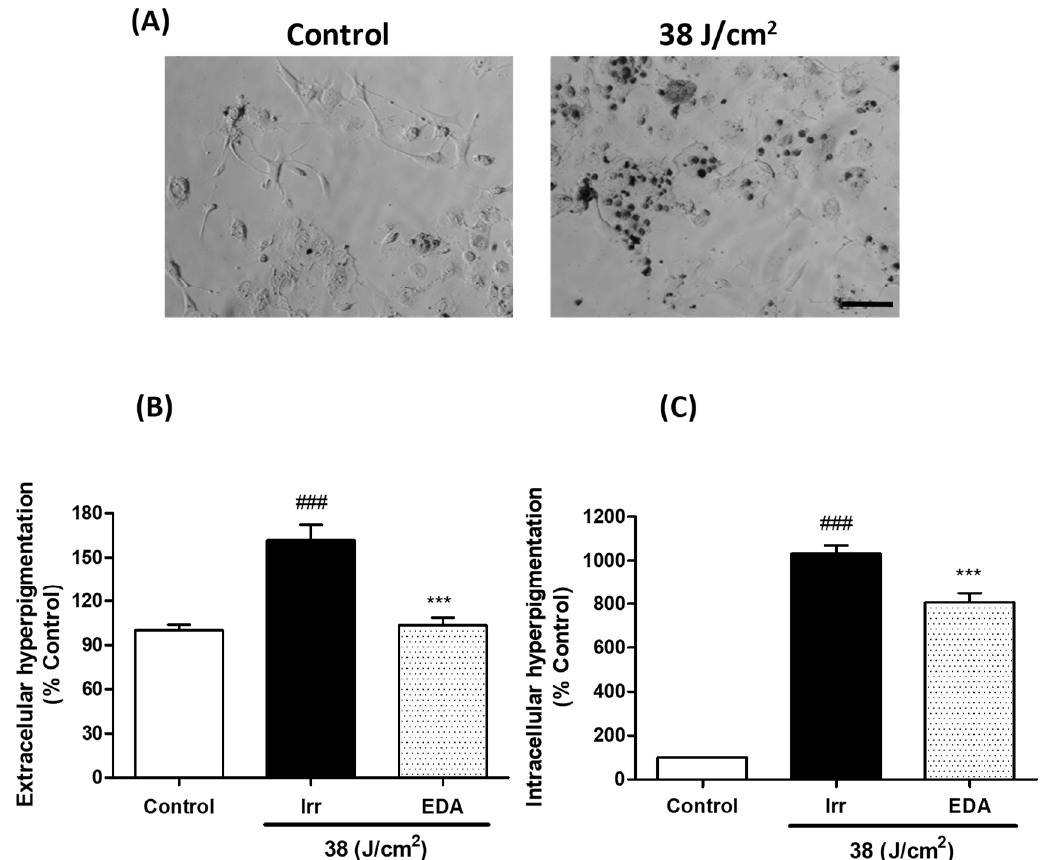
Figure 5. Extracellular and intracellular hyperpigmentation in melanocytes exposed to artificial blue light and pre-treatment with EDA. Microphotographs show how control and irradiated melanocytes have different amounts of melanin dark granules ( A ). Cells were incubated with EDA 0.1 mg/mL for 24 h, irradiated (38 J/cm 2 ), fresh medium replaced and extracellular ( B ) and intracellular ( C ) melanin pigments collected, solubilized and quantified 3 h later by absorbance measurements ( n ≥ 4). Data were normalized by mg protein and expressed as % of control cells. Data are shown as mean ±SEM. ### p < 0.001 vs control; *** p < 0.001 vs irradiated. Scale bar: 50 µm.